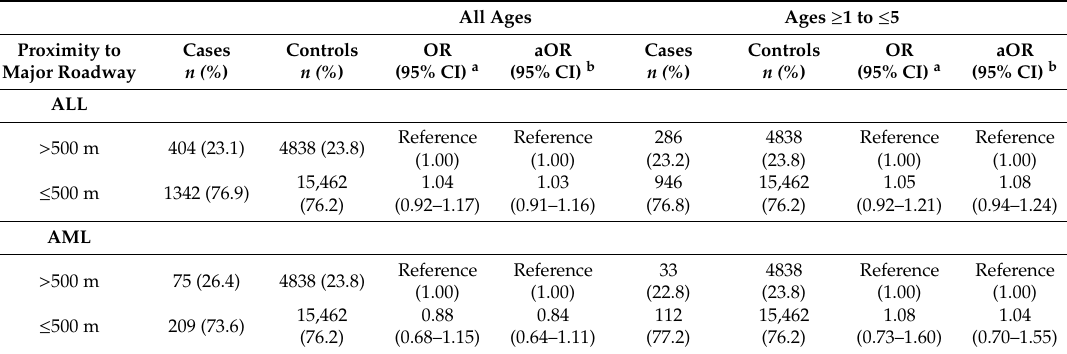
Table 3. Associations between maternal residential proximity within 500 m of a major roadway and leukemia in o ff